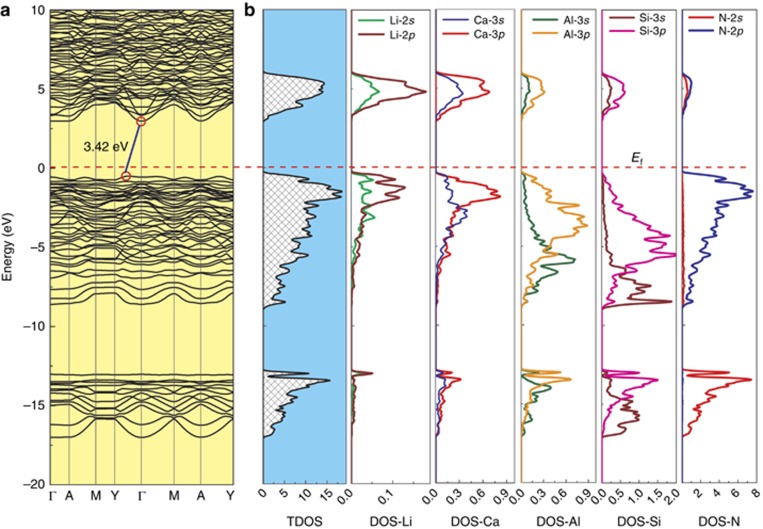
(a) Band structure and (b) total and atomic (Ca, Li, Al, Si, N) density of states of Ca1−xLixAl1−xSi1+xN3 (x=0.20).